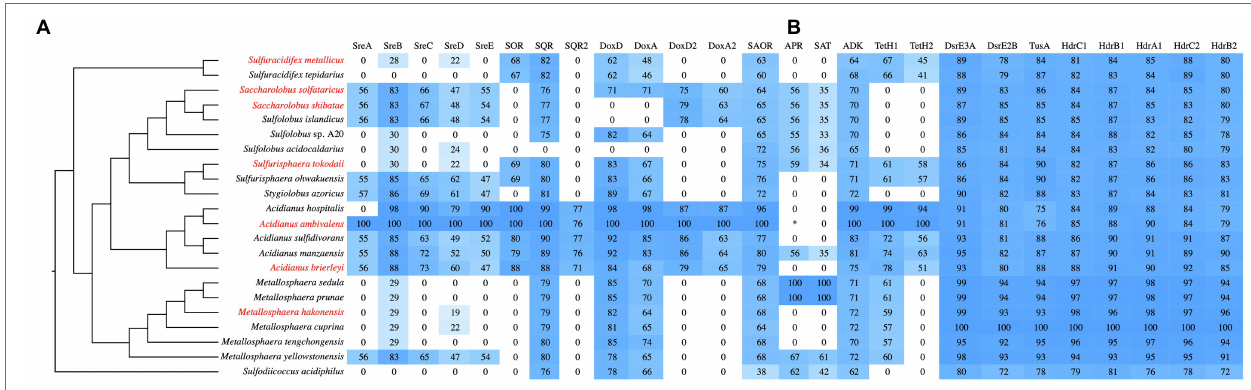
FIGURE 3 | Phylogenetic relationship of the proteins related to sulfur metabolism in the Sulfolobales. (A) Phylogenetic tree based on whole-genome sequences constructed by using a Composition Vector (CV) approach (Qi et al., 2004; Zuo and Hao, 2015). K-tuple length: 5. The reclassified species are highlighted in red. (B) Protein related to sulfur metabolism within the Sulfolobales and their percentage identity at the amino acid level (blastp, coverage >80%). Acidianus ambivalens , Metallosphaera sedula , and Metallosphaera cuprina proteins are used as queries. Sre, sulfur reductase; SOR, sulfur oxygenase reductase; SQR, sulfide:quinone oxidoreductase; DoxD, thiosulfate:quinone oxidoreductase (TQO) small subunit; DoxA, TQO large subunit; SAOR, sulfite:acceptor oxidoreductase; APR, APS reductase; SAT, ATP sulfurylase; ADK, adenylate kinase; TetH, tetrathionate dehydrogenase; Dsr, disulfide reductase; Tus, tRNA 2-thiouridine synthesizing protein; and Hdr, heterodisulfide reductase. *, the APR activity was detected in Acidianus ambivalens (Zimmermann et al., 1999), while no homologous sequence was found when use APR sequence of Metallosphaera sedula as